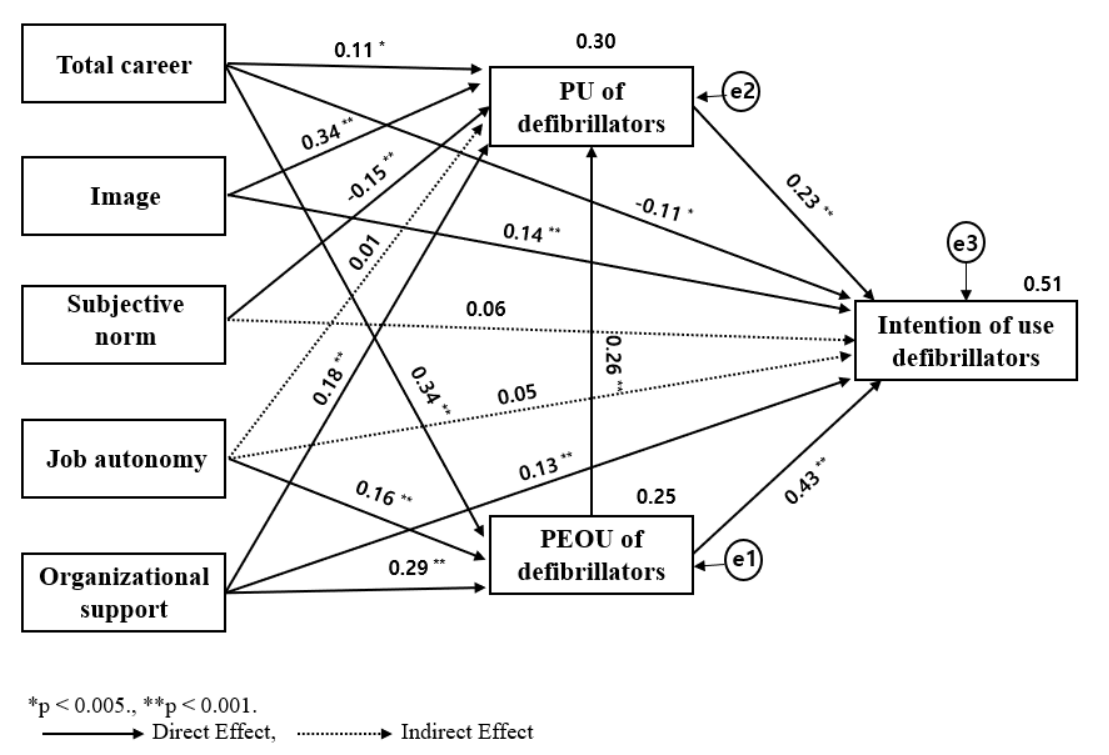
Figure 2. Modified model of factors influencing intention to use defibrillators of clinical nurses.